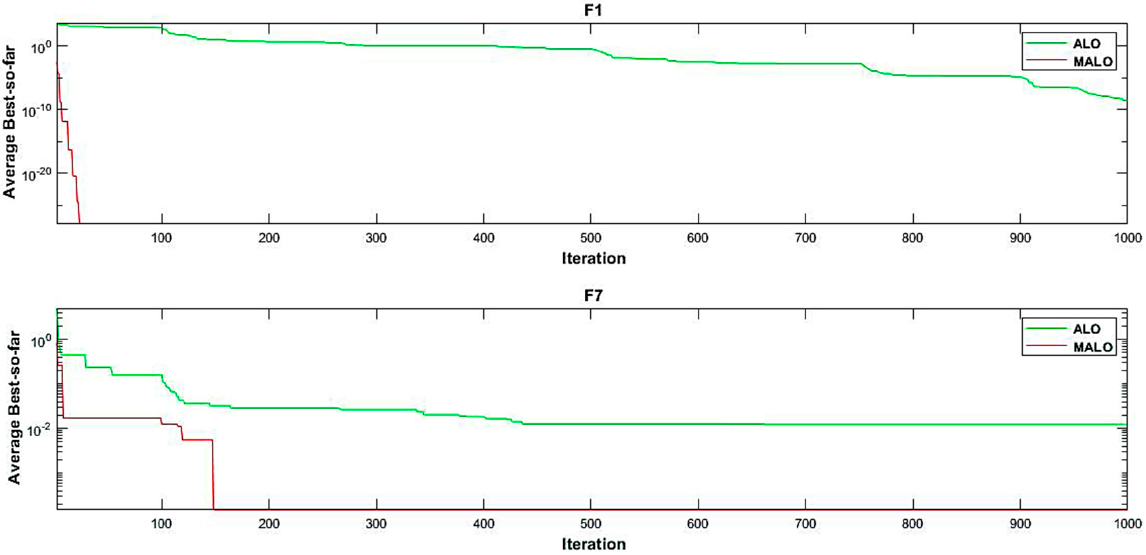
Figure 5. Convergence curves of ALO and MALO on some of the benchmark functions (1000 itera- tions).